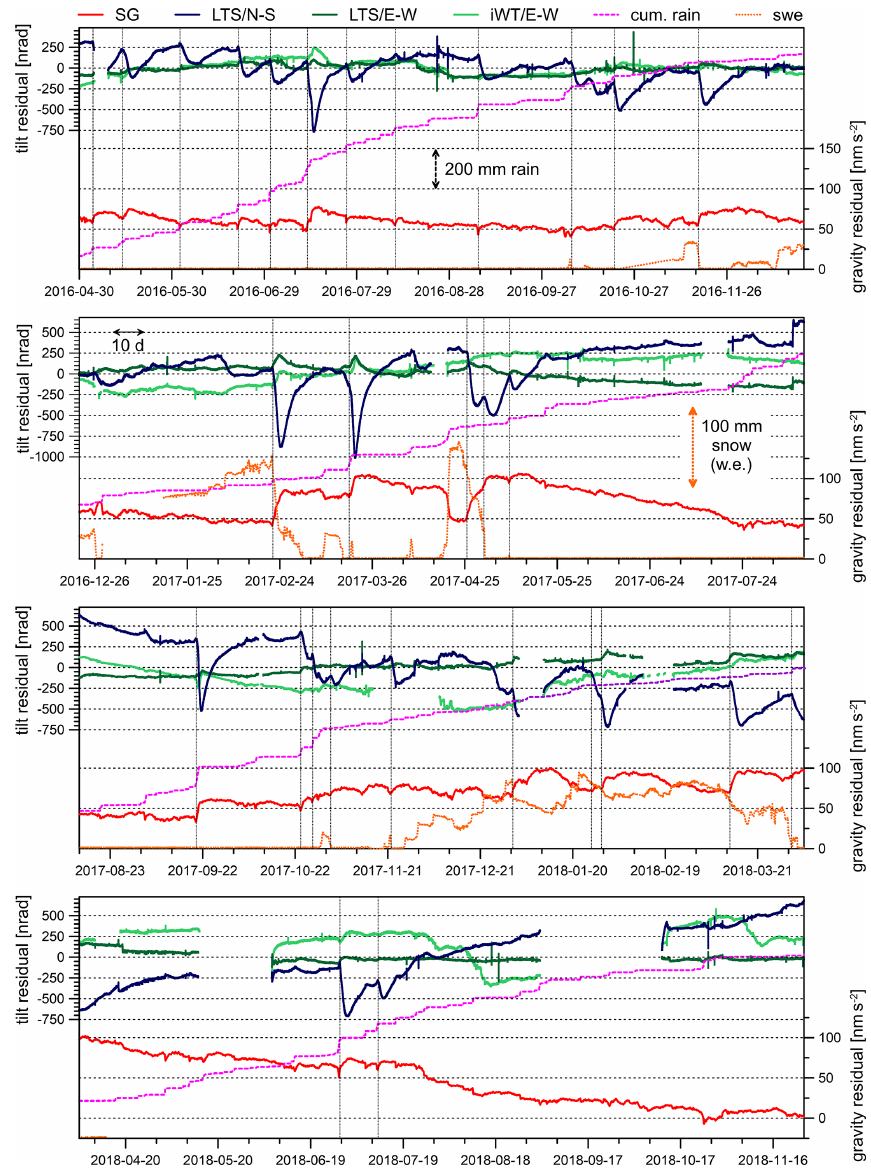
Figure 4. Comparison of gravity and tilt residuals, showing gravity (red), N–S tilt (LTS – dark blue), E–W tilt (LTS – dark green; iWT – light green), cumulative rain (dashed magenta line); snow water equivalent (dotted orange line). Scales for rain and snow (water equivalent) are indicated by arrows. Vertical dotted lines mark the onset of hydrologically induced long-term